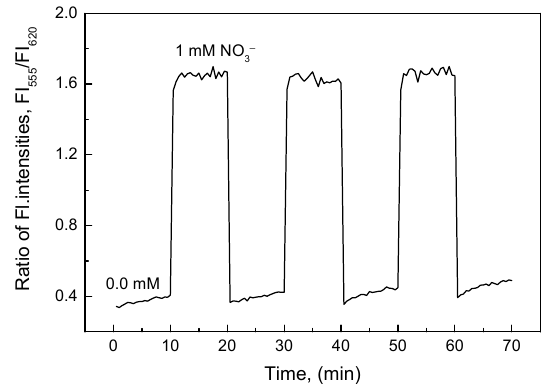
Figure 5 . Reversibility of the O17-HT-EC membrane when repeatedly exposed to a sequence of distilled water (0.0 mM) and 1 mM nitrate.